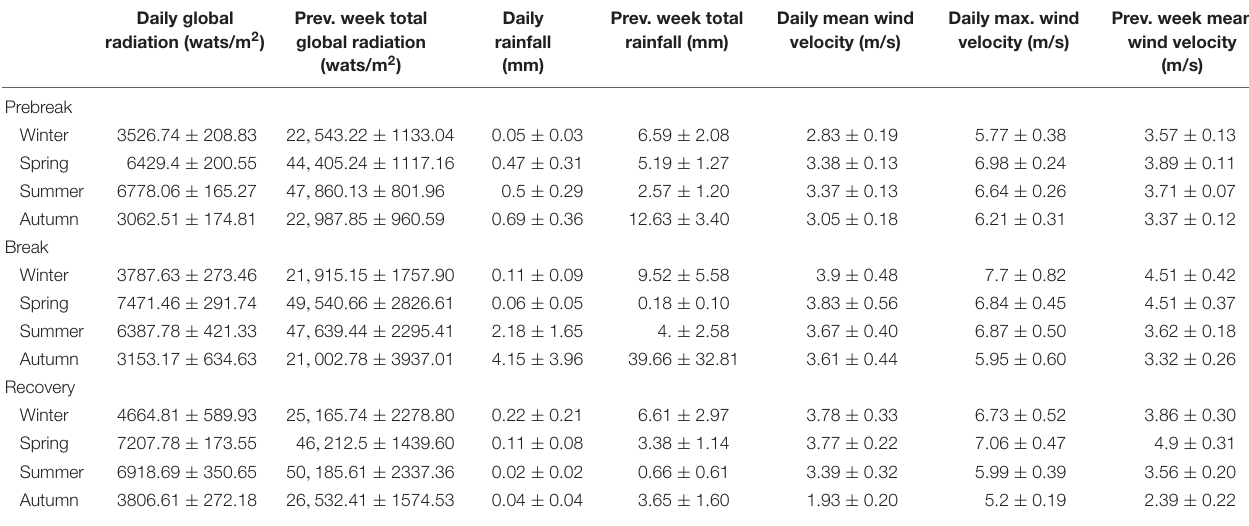
TABLE 1 | Seasonal average of the main climatic variables measured for the previous week and the day of sampling in the Mar Menor area in the three periods considered for the eutrophication process in the lagoon. Daily global radiation (wats/m 2